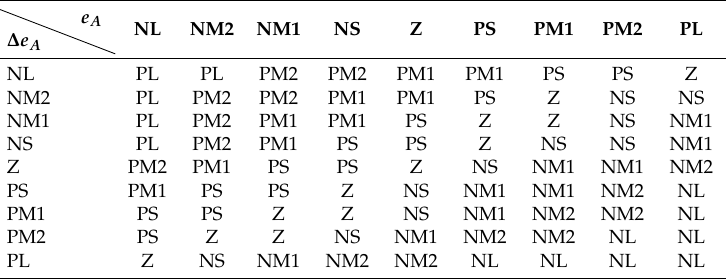
Table 1. Fuzzy control rules.